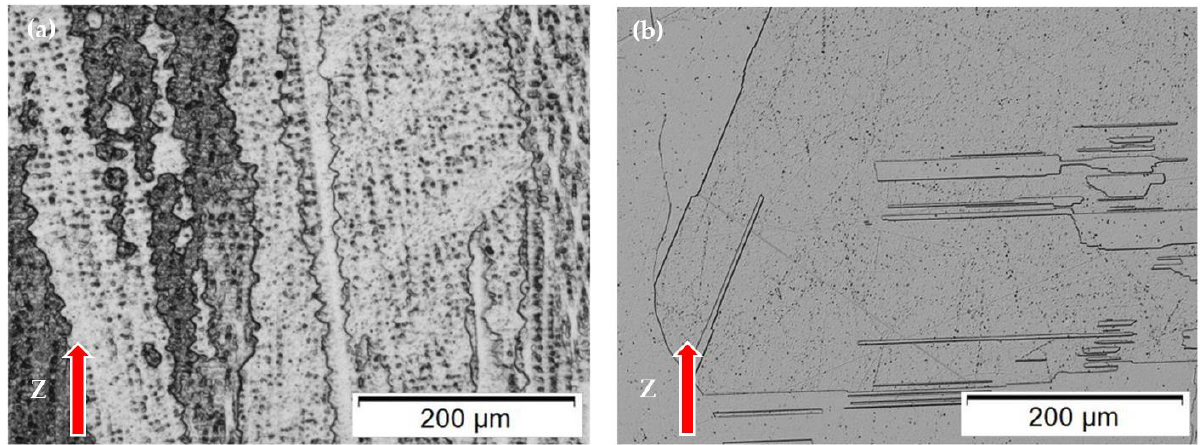
Figure 4. WAAM optical microscope images: ( a ) as-built, ( b ) heat-treated.